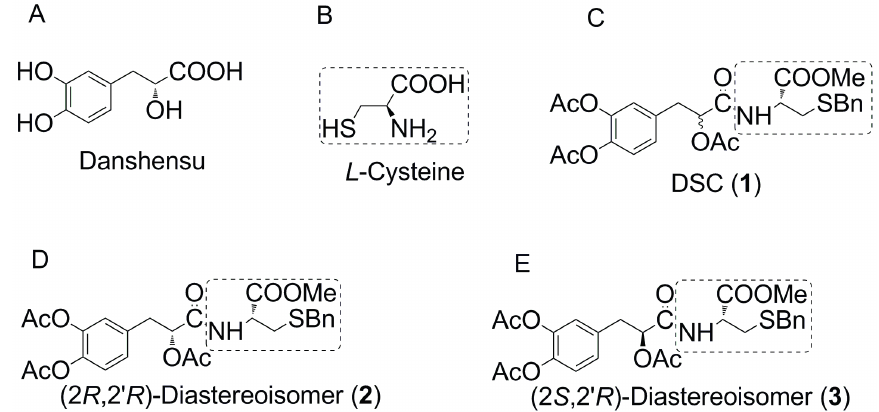
Figure 1. The structures of Danshensu, L -cysteine and their conjugated derivatives ( 1 – 3 ). ( A ) Danshensu; 2-acetoxy-3-(3,4-diacetoxyphenyl) propanamide (DSC); ( D ) (2 R ,2' R )-diastereoisomer of DSC; ( E ) (2 S ,2' R )-diastereoisomer of